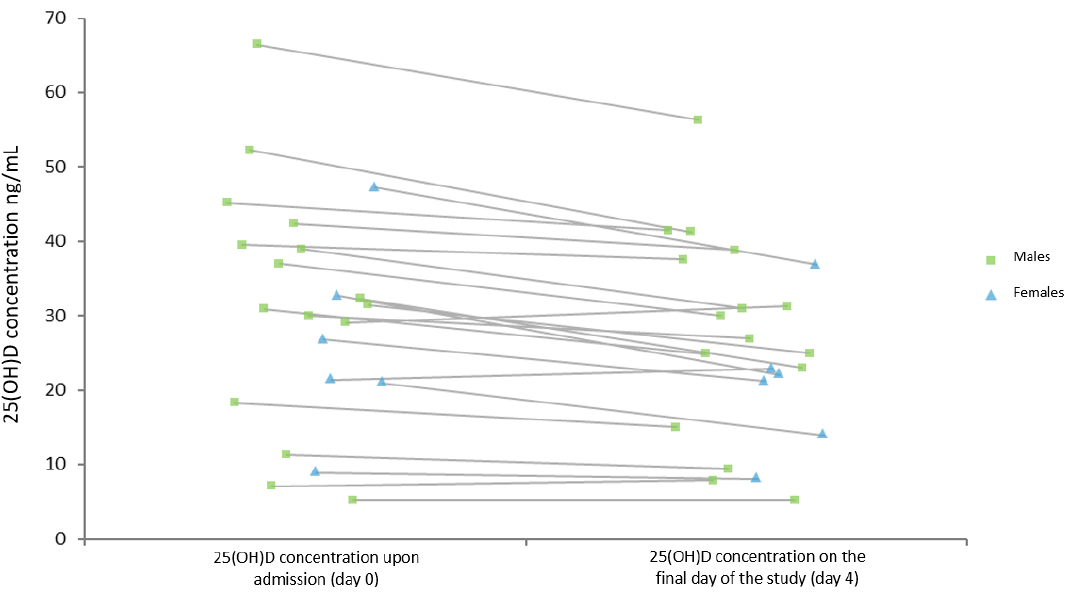
Figure 3. The comparison of 25-hydroxyvitamin D (25[OH]D) status in all patients between day of admission and day 4 of the study.